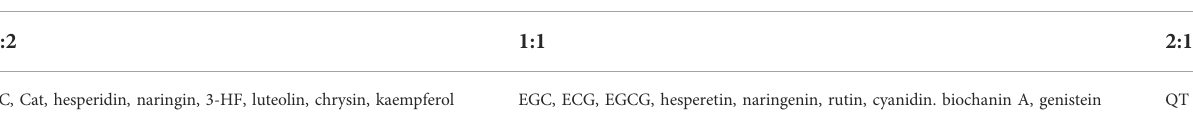
TABLE 3 Binding ratios of fl avonoids to Cu(II) ions in solution. Ratios were determined by titrating CuSO 4 into a 50 μ M solution of fl avonoid and monitoring the absorbance values of peaks that correspond to fl avonoid-Cu(II) complexes. Binding ratios (Cu: fl avonoid)